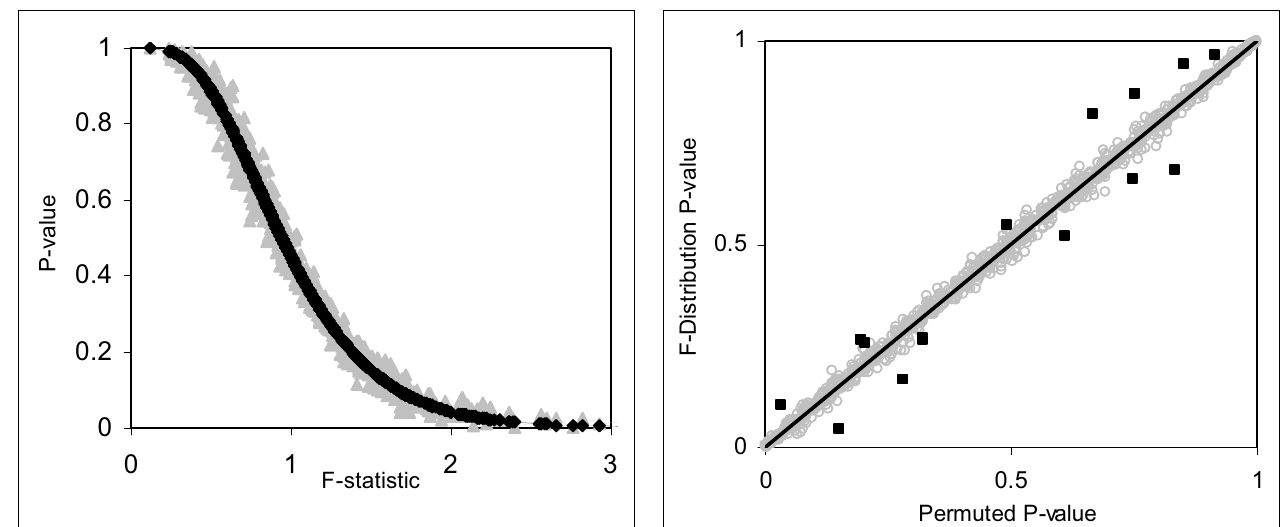
FIGURE 3 | Plot of permutation test-derived p -values as a function of the F -statistic in gray, the corresponding p -values derived from the F -distribution are overlaid in black for 10 samples ( N = 10) and 10 random variables ( P = 10) following a normal distribution with a mean of 0 and a variance of 1 simulated 1000 times. Five samples were coded as control (0) and five samples were coded as experiment (1). Table 3 | Level accuracy of F -distribution p -values as a function of decreasing sample size over 1000 simulations for a single dichotomous (categorical) predictor variable.